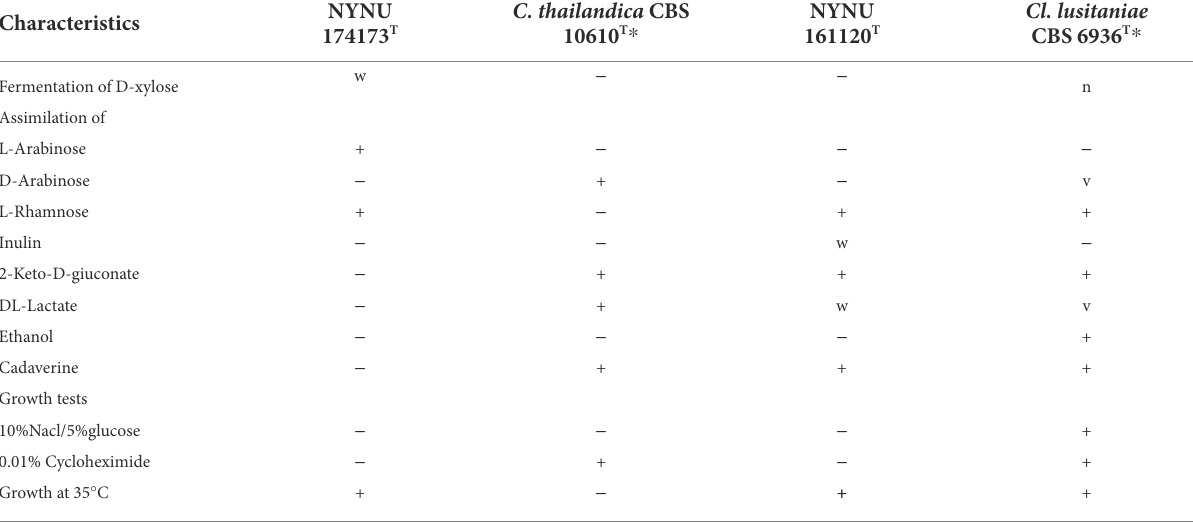
TABLE 3 Phenotypic characteristics that differed between the novel strains NYNU 174173 T and NYNU 161120 T and their closely related taxa. Characteristics